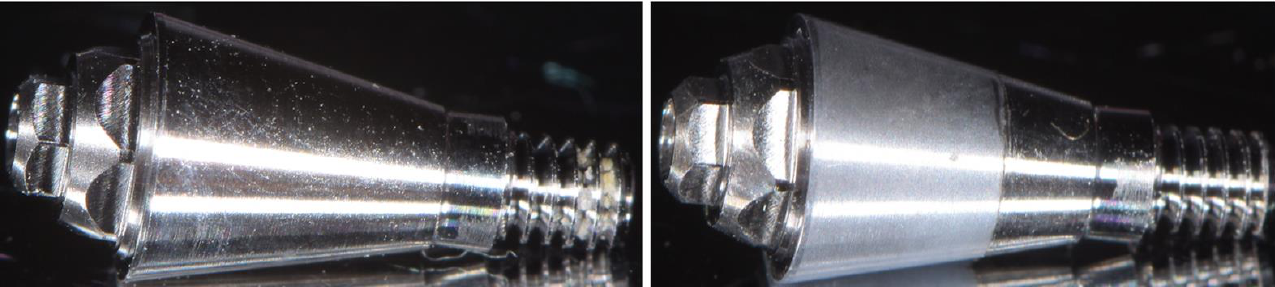
Figure 2. Image showing the macroscopic aspects of the two abutments used in the present study. Left : machined abutment; Right : super-latex abutment. Left : machined abutment; Right : superlattice